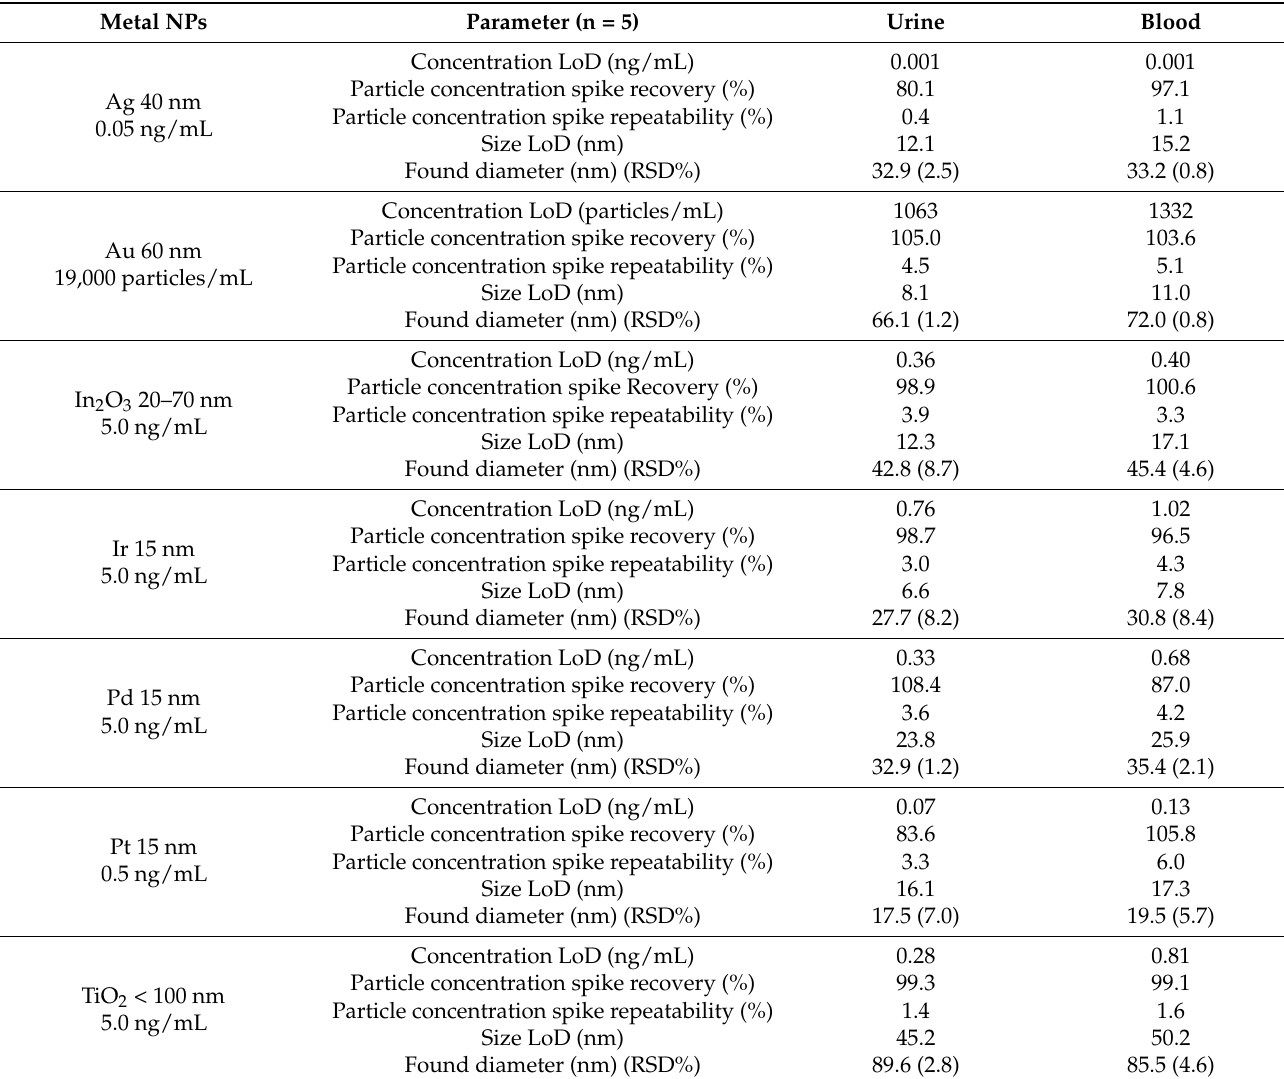
Table 2. Single Particle-Inductively Coupled Plasma-Mass Spectrometry (SP-ICP-MS) validation